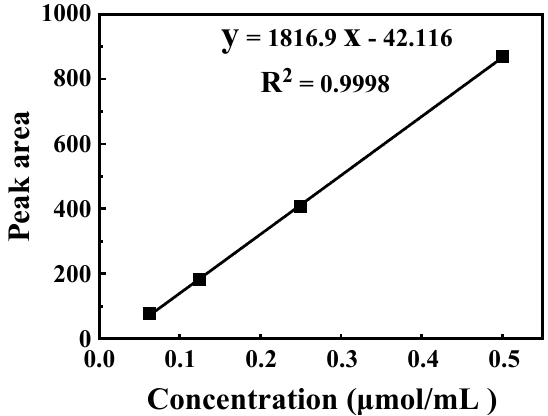
Figure 1. The concentration of sinigrin was diluted by gradient and determined by HPLC. Calculation formula: D1 = relative influence factor *X/m. (D1: contents of glucosinolates in dried mustard; Unit: μ mol/g DW; X:X value in the standard curve; m: quality of mustard samples).